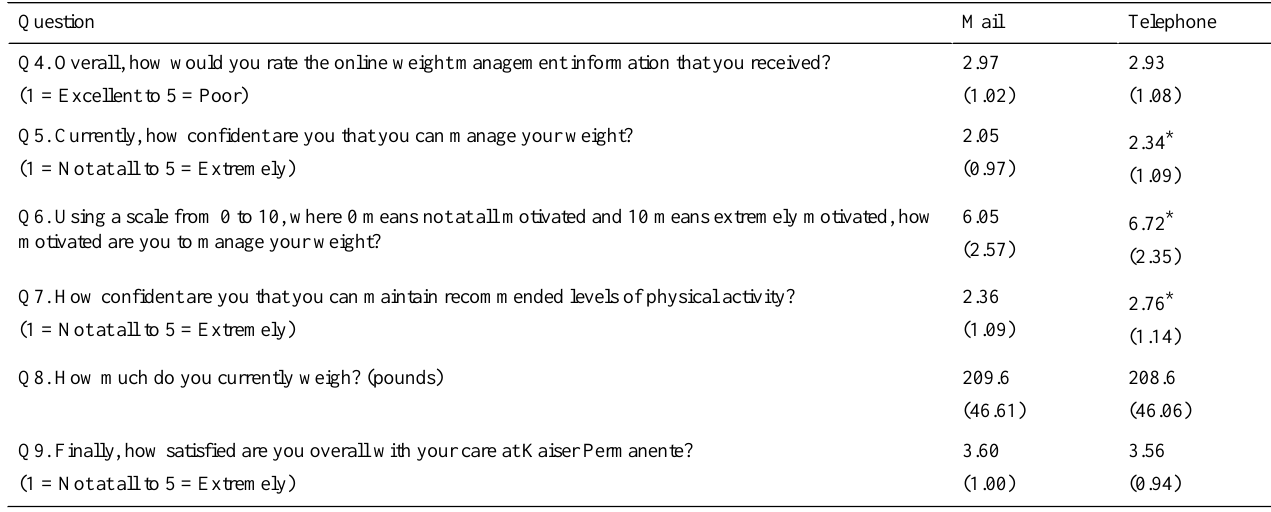
Table 4. Mean responses (SD) to nonresponse follow-up measures, by mode